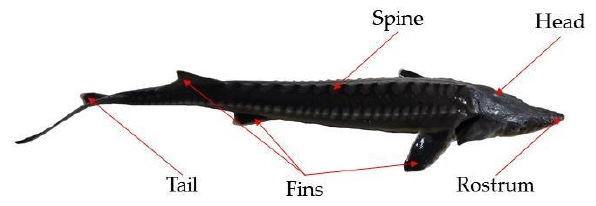
Figure 1. Sturgeon body structure.